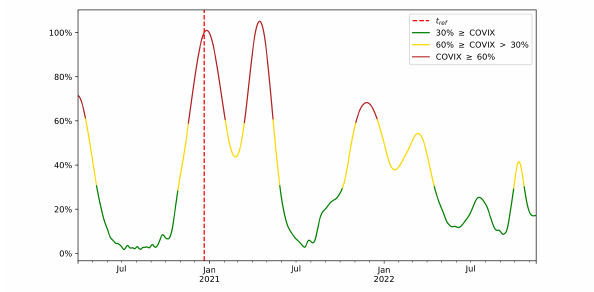
Figure 6. COVIX p t , t ref q with t ref “ 21 December 2020 . The dashed red line indicates the chosen reference date. The multi-coloured line indicates the COVIX value at any given date. The colour of the line indicates whether the COVIX is above 60% (red), between 60% and 30% (yellow), or below 30%